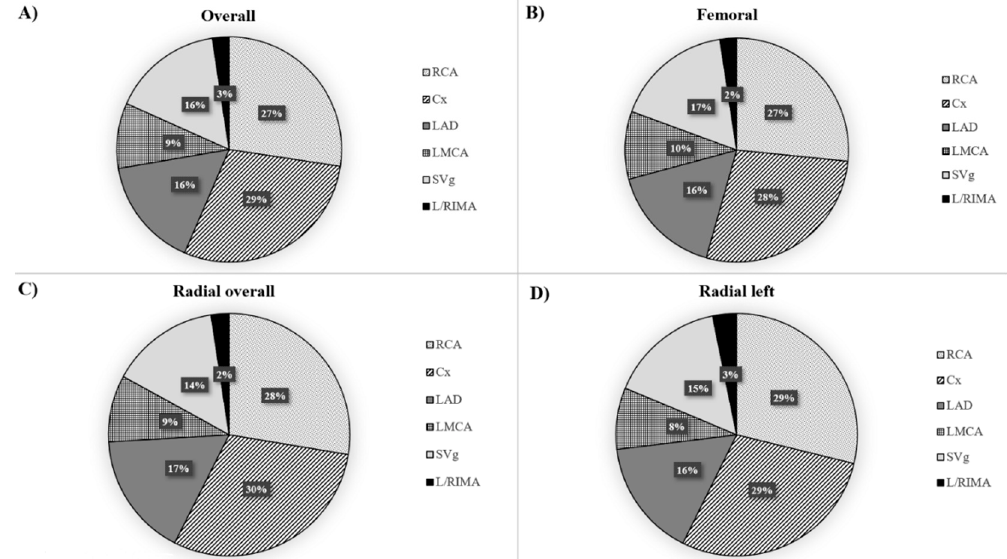
Figure 2. Number of PCIs performed in patients previously treated withCABG according to vascular access in following years (2014-2018). PCI = percutaneous coronary intervention.